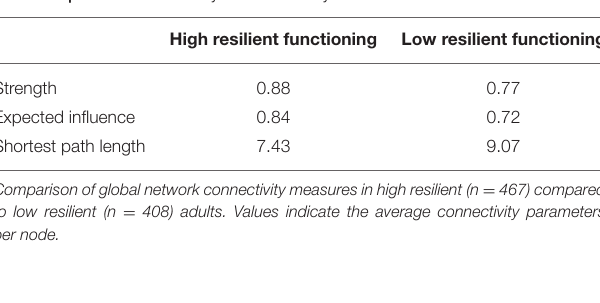
TABLE 2 | Global connectivity of self-efficacy